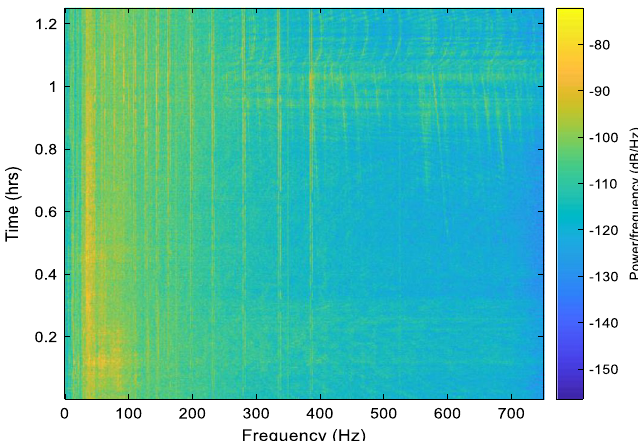
Fig. 5 The frequency spectrum of the signal received by array element No.